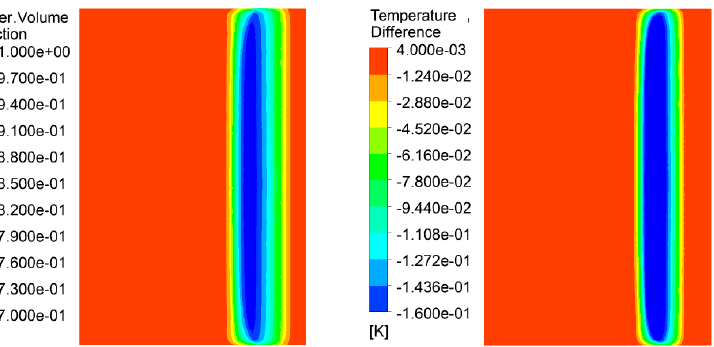
Figure 13. Distribution of water volume fraction and temperature difference on upper side of hydrofoil, σ = 1.9. CFD.